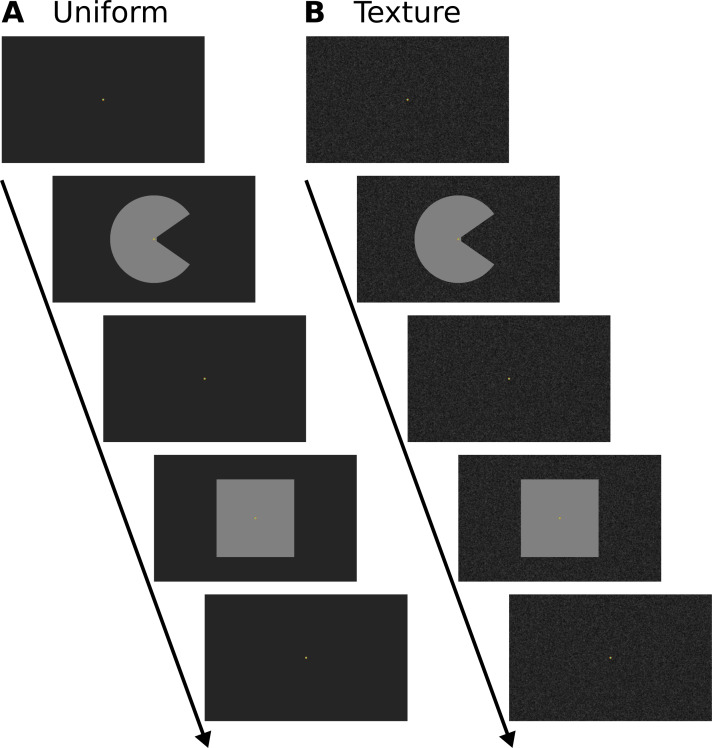
Stimulus design of the control experiment.The purpose of the control experiment was to investigate the role of the background and the stimulus shape. Participants were presented with a static ‘Pac-Man’ stimulus (same as in the main experiment, static control condition), and a square with the same area as the ‘Pac-Man’. Stimuli were presented in a block design. In separate runs, these stimuli were presented on a uniform background (A) and a texture background (B, same as in the main experiment). The order of stimulus conditions was randomised. Participants performed a central fixation task (as in the main experiment). See Figure 1—figure supplement 1 for a higher-resolution image of the texture background. Videos of the stimuli are available online (https://doi.org/10.5281/zenodo.2583017).